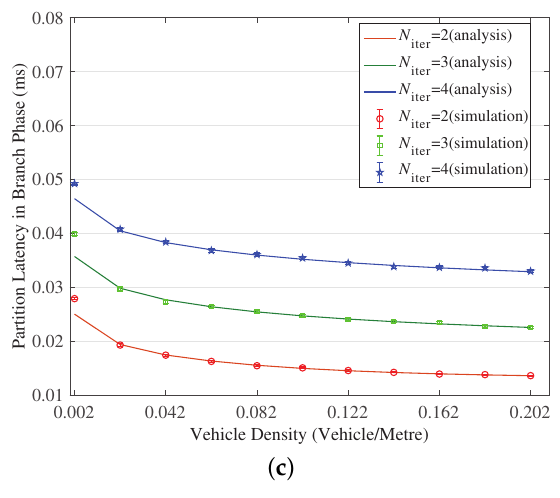
Figure 5. Validation of the model for partition latency in Branch Phase. ( a ) When ( N iter , N part ) = ( 2,3 ) ; ( b ) When ( N iter , A ) = ( 2,2 ) ; ( c ) When ( N part , A ) = ( 4,2 ) .